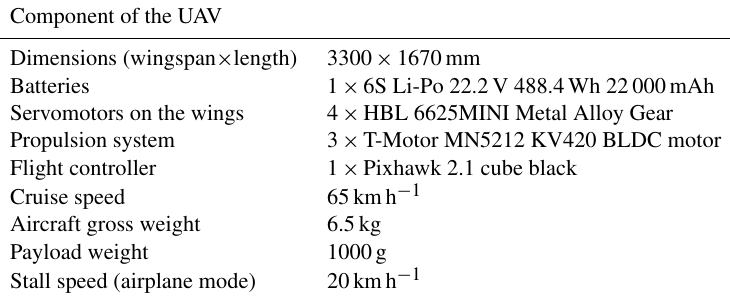
Table 1. Specifications of Kapetair VTOL UAV.